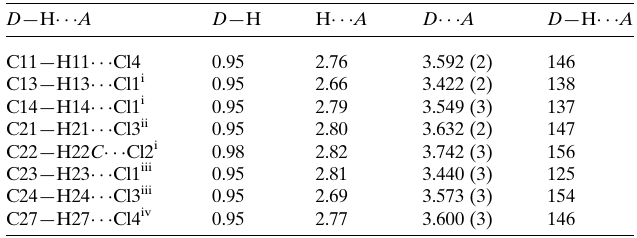
Table 2 Hydrogen-bond geometry (A˚ , (cid:2)